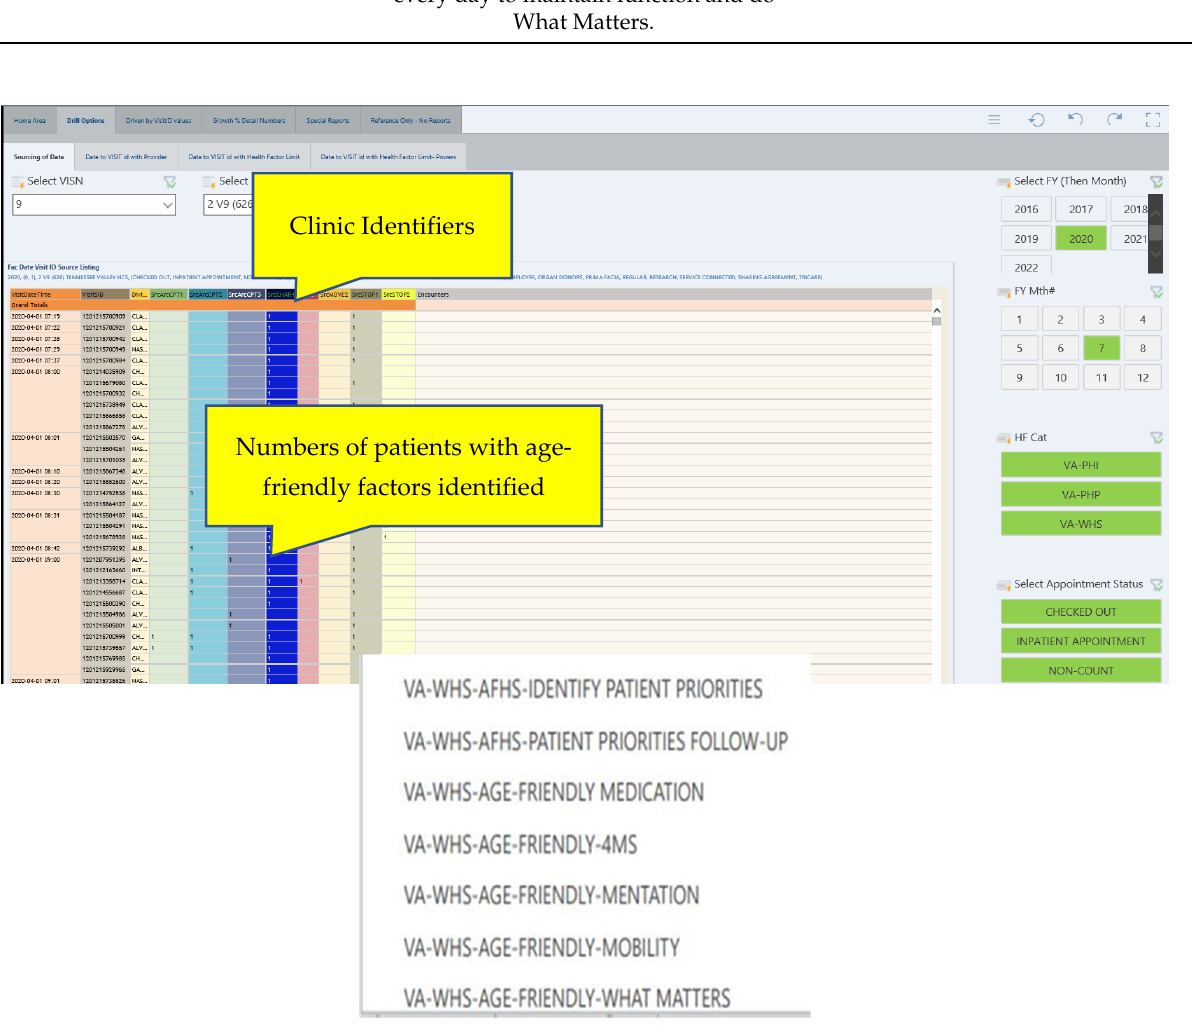
Figure 1 . Whole Health age-friendly dashboard (WH4ALL). Display visualizes the opening page of the national age-friendly dashboard with health factors addressed in the electronic health record by